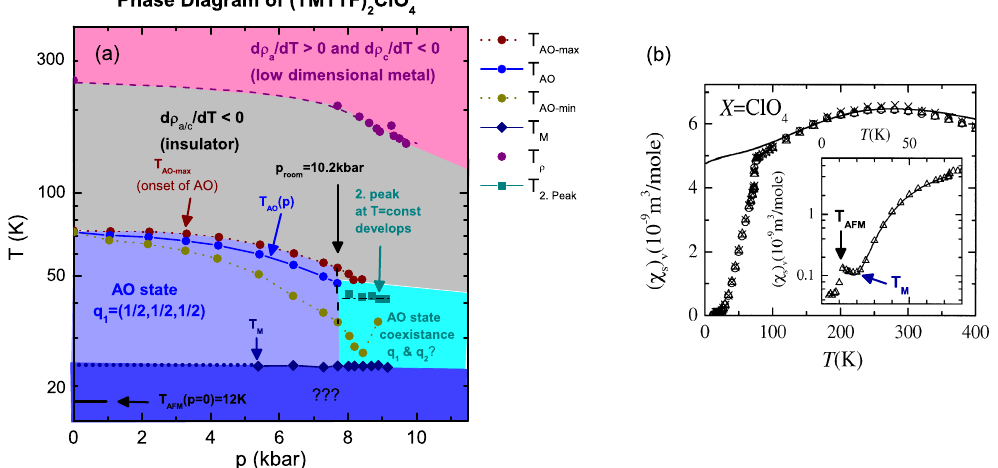
Figure 11. ( a ) The phase diagram of (TMTTF) 2 ClO 4 as obtained from resistivity measurements indicates various phase transitions. ( b ) Temperature-dependent susceptibility of (TMTTF) 2 ClO 4 as obtained from electron spin resonance (ESR) measurements (taken from Dumm et al. [82]). Two distinct drops in the ESR intensity can be identified, one at the AO transition and the other at the antiferrmagnetic order T AFM = 12 K. The onset of the plateau appears around T ≈ 20 K (indicated by the blue arrow), which coincides with the steep increase of the resistivity at T M